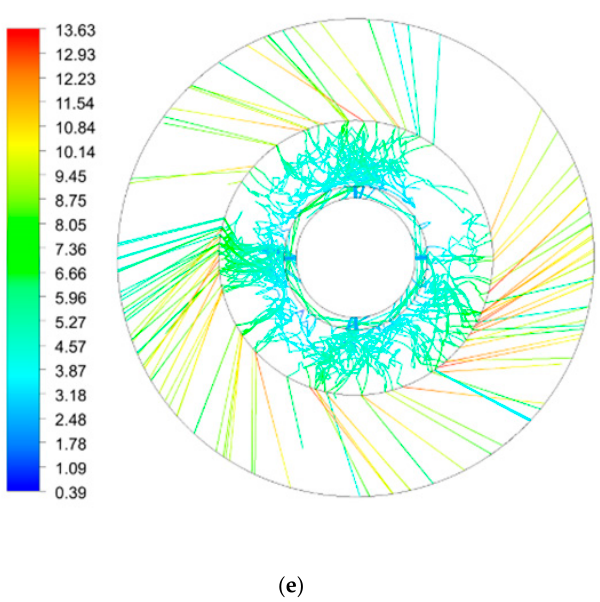
Figure 6. The velocity values and vectors under various initial droplet velocities and rotating speeds. ( a ) u 0 = 0.5 m / s, ω = 300 rpm; ( b ) u 0 = 0.5 m / s, ω = 600 rpm; ( c ) u 0 = 0.5 m / s, ω = 900 rpm; ( d ) u 0 = 1.5 m / s, ω = 600 rpm; ( e ) u = 2.5 m / s, ω = 600